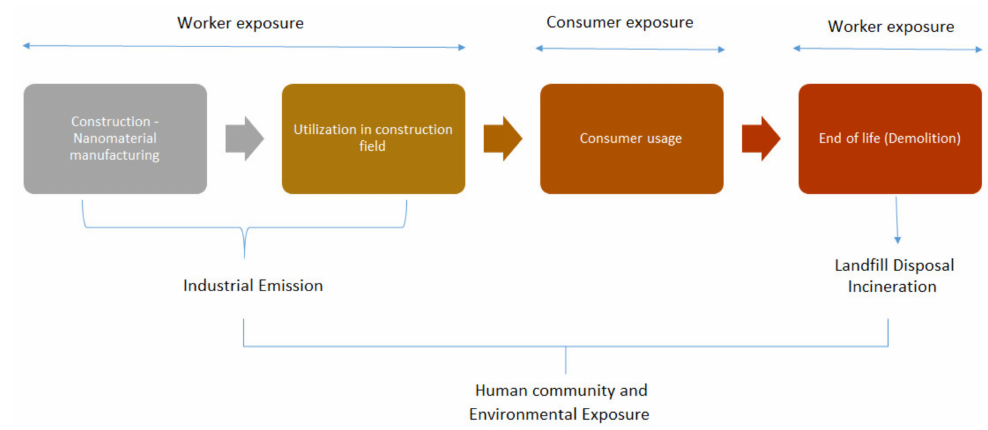
Figure 11. Potential exposure routes during the complete cycle of construction